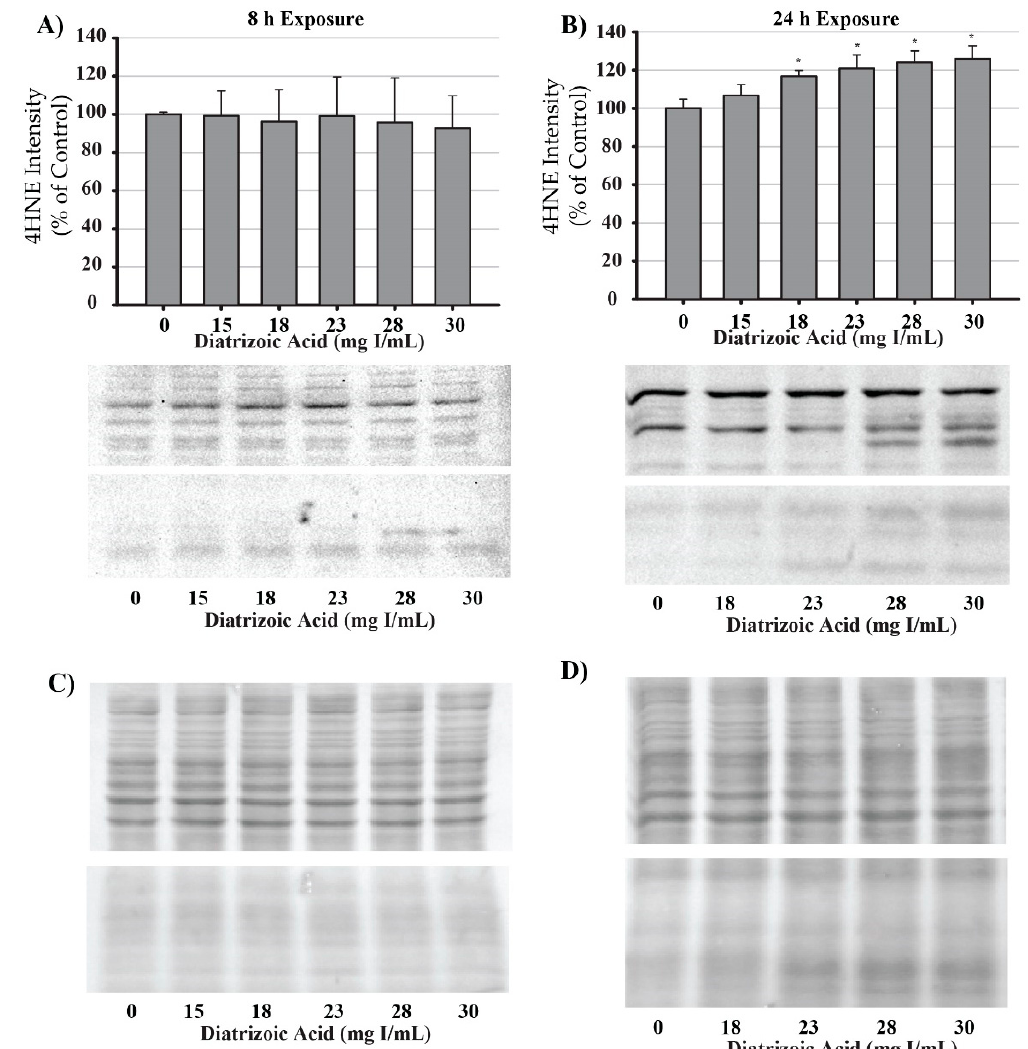
Figure 12. Diatrizoic acid e ff ects on 4-hydroxynonenol (4HNE) adduct formation in HK-2 cells. An increase in 4HNE protein adduct formation was evident in cell lysate following 24 h exposure ( B ) to 18–30 mg I / mL. Positive bands of 4HNE were unchanged after 8 h ( A ) DA exposure. Panels ( C ) and ( D ) depict 8 h and 24 h, respectively, for protein loading of 40 µ g per lane. Statistical di ff erence from 0 mg I / mL diatrizoic acid depicted by an asterisk (* p < 0.05). Values represent mean ± SEM for three independent experiments.